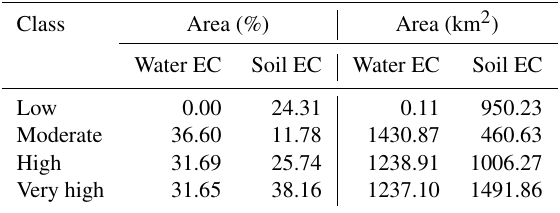
Table 5. Areas of the classes for water and soil EC. Class